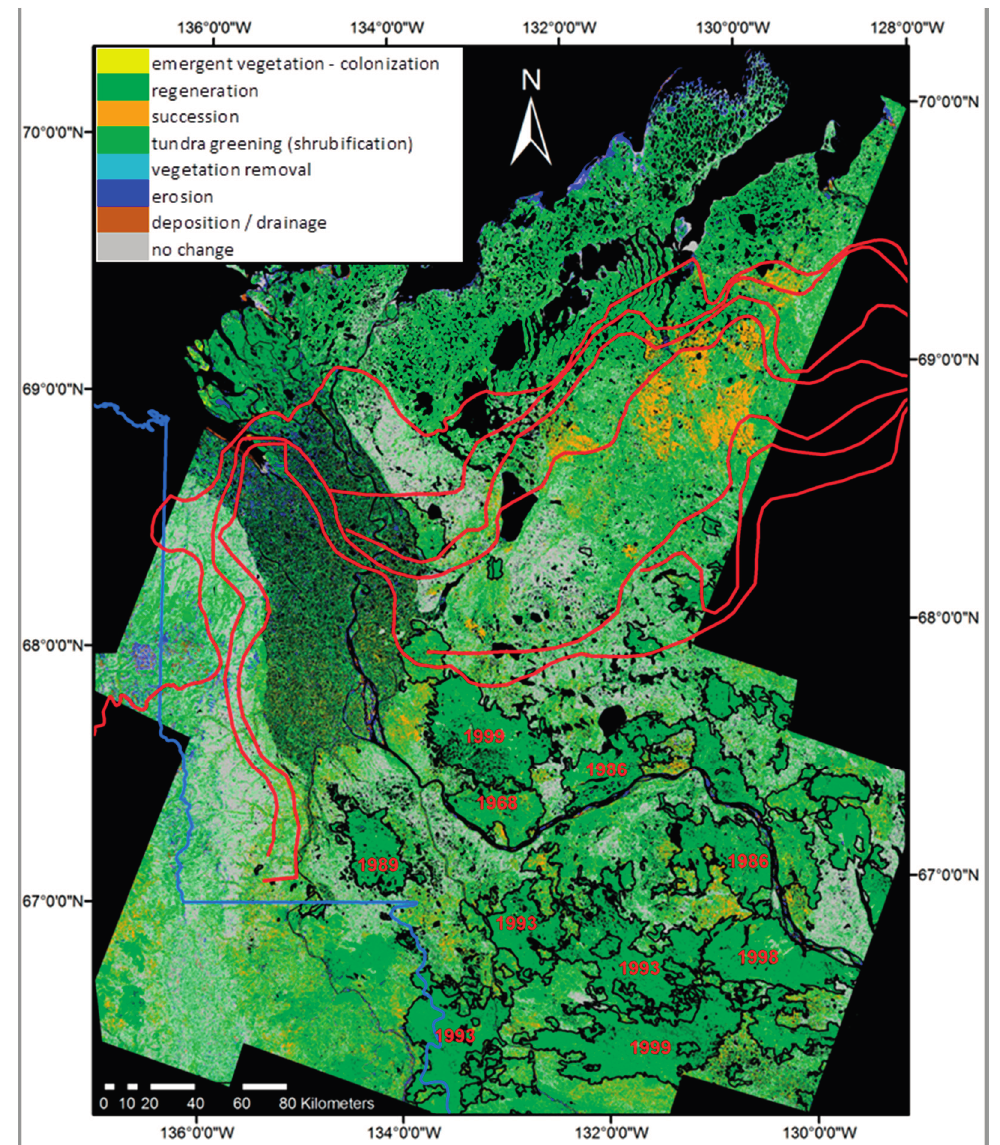
Figure 5. Change map of the Mackenzie Delta region classified to eight change